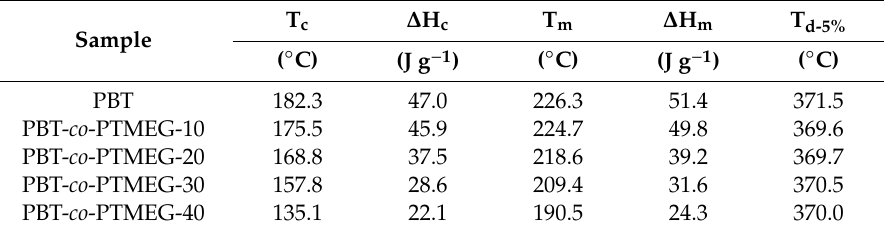
Figure 3. DSC curves of PBT and PBT- co -PTMEG copolymers in ( a ) 1st cooling process and ( b ) 2nd heating process at a rate of 10 °C min − 1 . Table 2. Thermal properties of PBT and PBT- co -PTMEG copolymers.